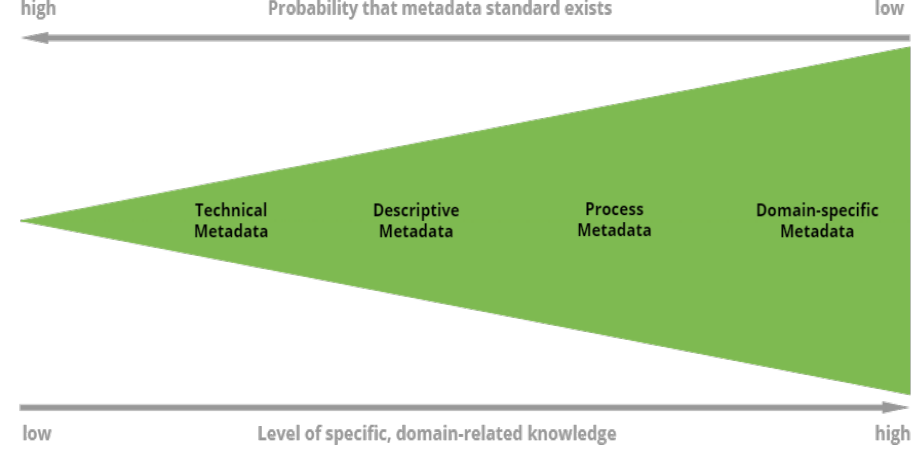
Figure 13. Metadata categories with the specificity level. With an increasing level of specificity, the probability of existing metadata standard is decreasing (Redrawn, based on